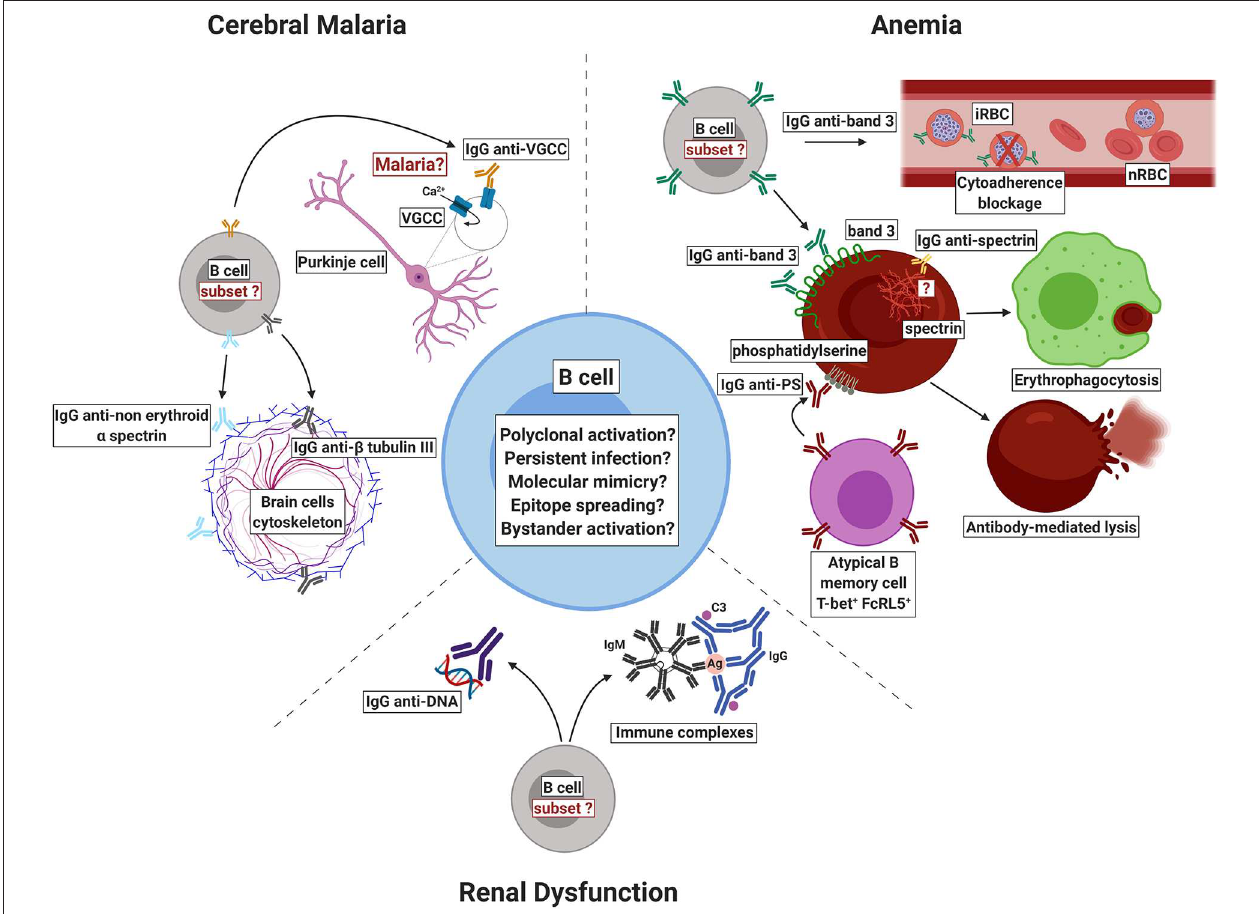
FIGURE 1 | Schematic representation of self-reactive antibodies and their proposed role in the pathogenesis or protection against malaria. Autoantibodies that recognize host’s own molecules have been reported in patients with malaria but the mechanisms by which such autoimmune response is induced are still to be completely elucidated. In infections due to P. falciparum , self-reactive immunoglobulins against voltage-gated calcium channel (VGCC), non-erythroid alpha spectrin, and beta tubulin III have been associated to cerebral malaria. In P. falciparum and P. vivax infections, anti-phosphatidylserine antibodies (IgG anti-PS) have been shown to recognize non-infected red blood cells (nRBCs) exposing phosphatidylserine, mediating their clearance and contributing to malaria-associated anemia. During P. vivax malaria, autoimmune responses to anion exchanger 1 (band 3 protein) have been implicated in the removal of nRBCs by decreasing their deformability and enhancing their uptake by THP-1 cells. On the other hand, in P. falciparum malaria, anti-band 3 self-reactive antibodies have been associated to protection through the blockage of cytoadherence. Antibodies to erythrocytic spectrin are elicited during P. vivax malaria but it remains unclear how they bind to cytoplasmic proteins. It has been hypothesized that the inflammation triggered by infection may damage brain cells, leading to the exposure of spectrin, which may activate the complement, amplifying neuronal damage. Finally, anti-DNA autoantibodies and immune complexes containing self-immunoglobulins have been suggested to play a role in renal dysfunction by depositing in renal tissues. iRBC: infected red blood cell. Ag: antigen. C3: complement component 3. Figure created with